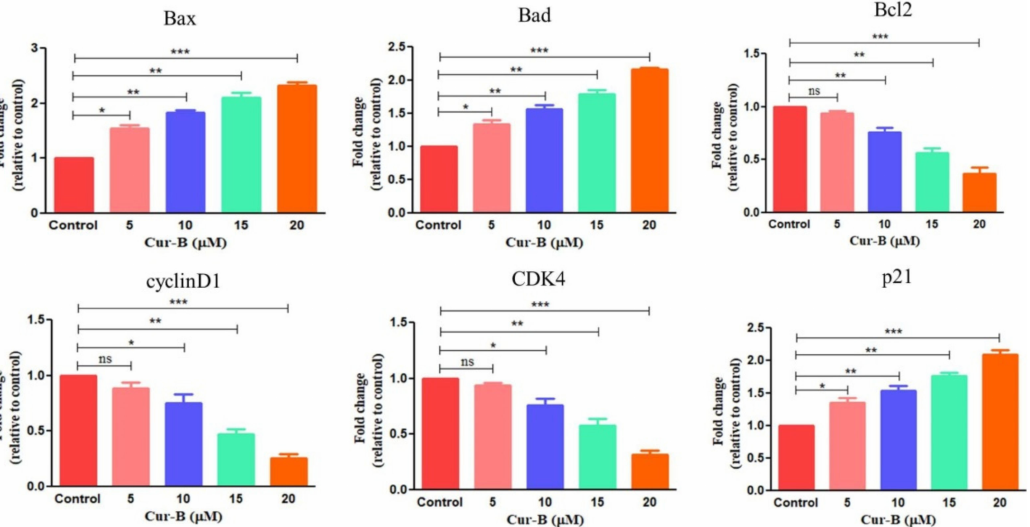
Figure 6. Effect of Cur-B on modulating mRNA expression of various genes involved in apoptosis and cell cycle regulation in PC-3 cells. * p < 0.05, ** p < 0.01, *** p <